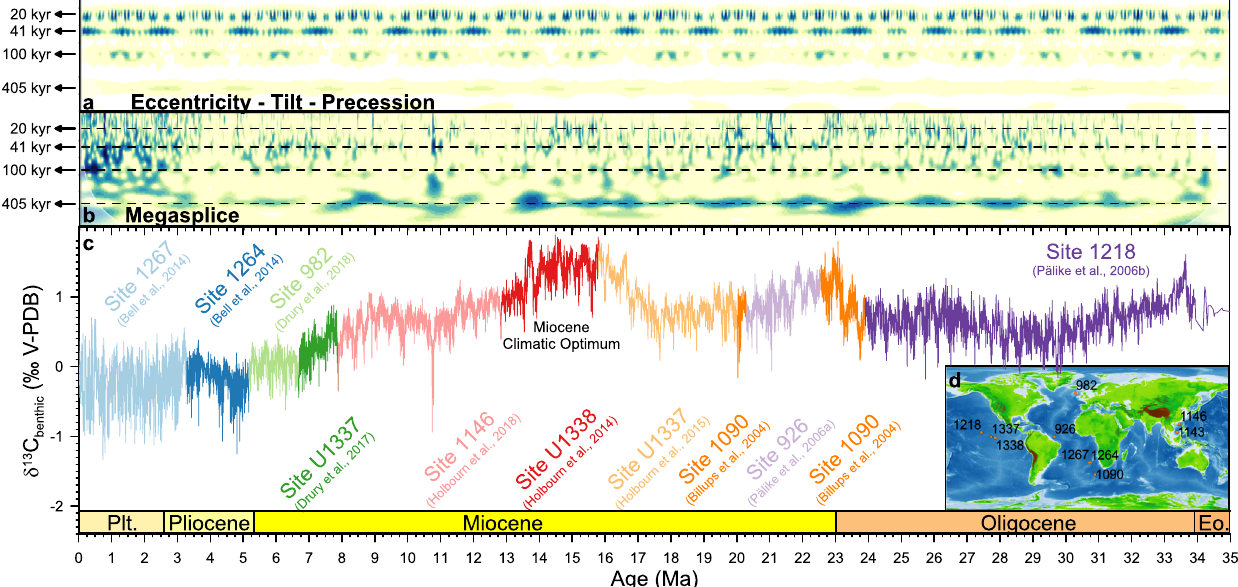
Fig. 1 Benthic δ 13 C megasplice. Wavelet spectrograms of a the astronomical rhythms (eccentricity – tilt – precession 58 composite) and b the benthic δ 13 C megasplice visualize the strong response of carbon cycle dynamics to 405-kyr long eccentricity. c , d The megasplice consists of nine globally distributed benthic carbon isotope records, all retrieved by the IODP and its predecessors: Site 926 75 , 982 19,76 , 1090 77 , 1146 7,21 , 1218 10 , 1264 18 , 1267 18 , U1337 20,70 and U1338 78 . World map after Amante and Eakins 79 .